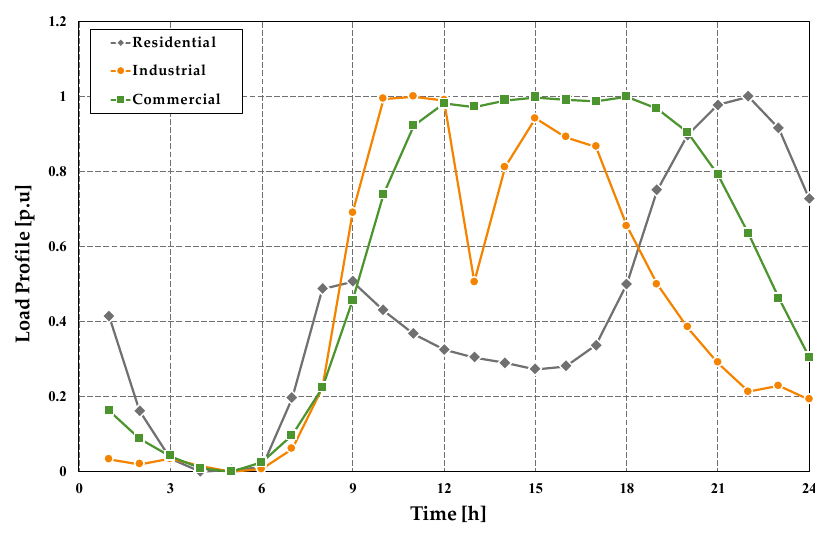
Figure 7. Load profile by customer type.